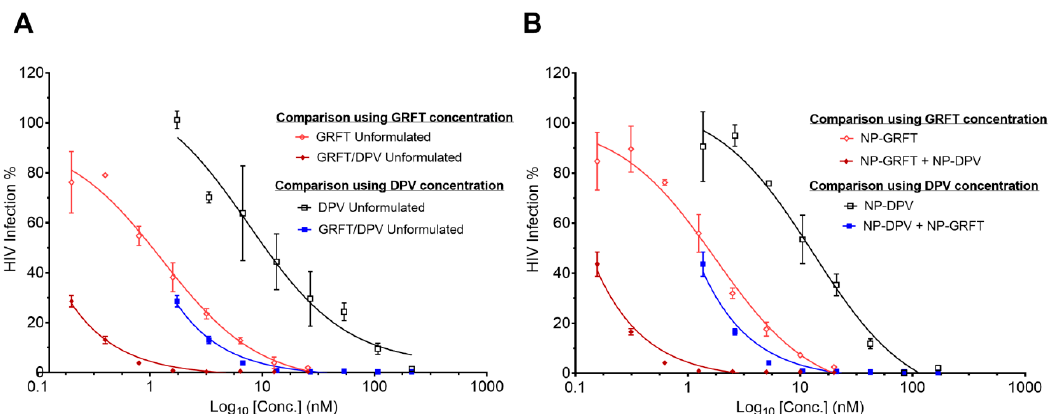
Figure 7. Strong synergistic effect of GRFT and DPV in free drug combination, in NP-GRFT and NP-DPV combination. The dose-response curve shows antiviral activity of ( A ) free GRFT, free DPV or combination of free GRFT and free DPV. ( B ) GRFT-loaded nanoparticles (NP-GRFT), DPV-loaded nanoparticles (NP-DPV) alone or in combination (NP-GRFT + NP-DPV). At a 1:8 molar ratio (GRFT and DPV), the antiviral activity of each drug in combination showed a significant reduction in %HIV infection (IC 50 cannot be computed) compared to single ARV drug in unformulated or encapsulated forms. No difference in anti-HIV activity of GRFT or DPV were found in unformulated or nanoparticle combinations.